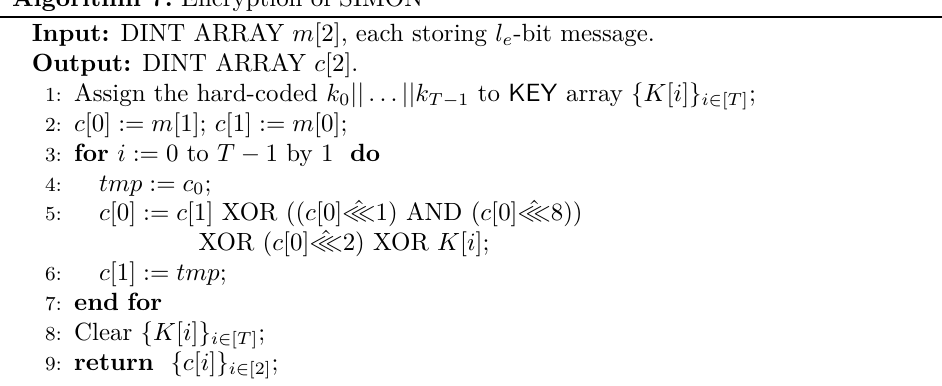
Algorithm 7: Encryption of